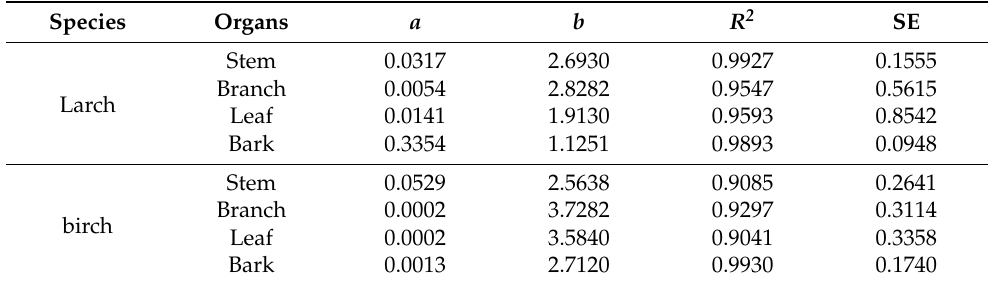
Table 2. Related parameters of allometric growth equation of tree species